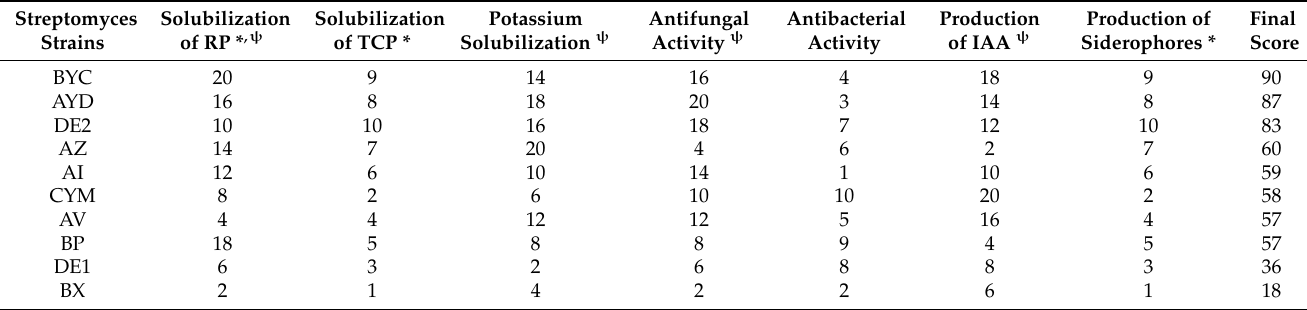
Table 2. The criteria score for screening of the 10 selected Streptomyces sp. with multifaceted PGP activities from sugar beet rhizospheres in Beni Mellal, Morocco. The numbers in the table represent a score out of 10, assigned to each strain according to its solubilization capacity, antimicrobial activity and the rate of IAA and siderophore release. Streptomyces Solubilization Strains of RP * ,